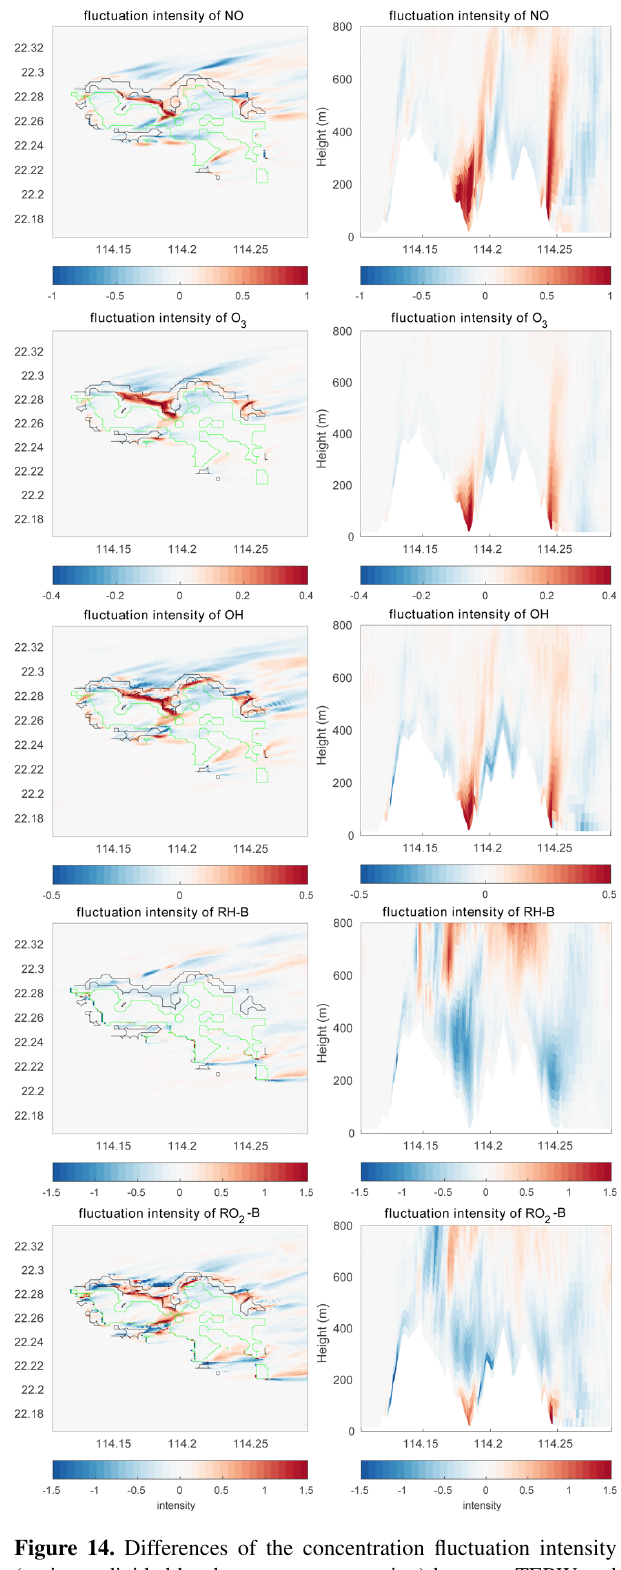
Figure 14. Differences of the concentration fluctuation intensity (variance divided by the mean concentration) between TERW and HETF (TERW – HETF) at the first level (left panels) and the verti- cal cross section along latitude 22.275 °N (right panels). The black line shows the urban area, and the green line shows the forest